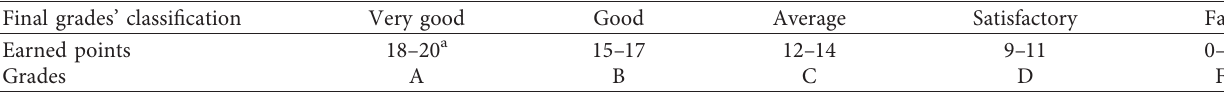
Figure 7: Simplified ANN-based M-learning model architecture. Table 3: Learners’ performance scores classified into five-level